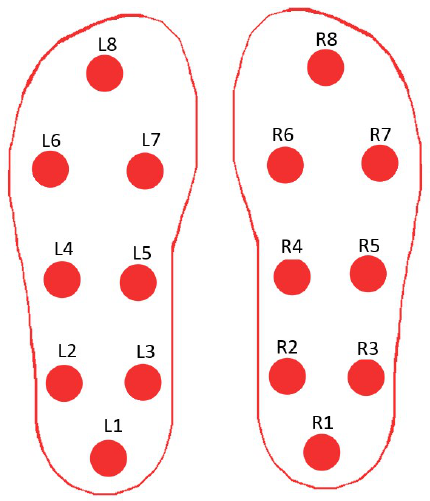
Figure 2. Placement of the 16 sensors under both